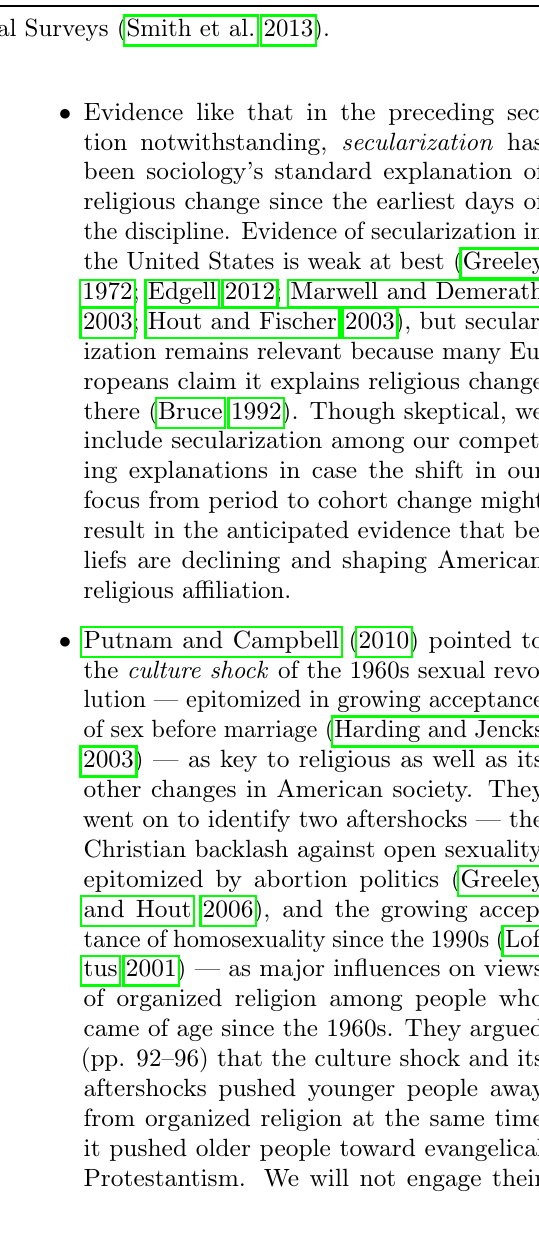
Table 1: Percentage Distributions of the Extent to Which People Describe Themselves as Religious and Spiritual by Some or No Religious Preference: Adults, United States, 2012. Some religion No religion Extent Religious Spiritual Religious Spiritual Very 23 32 3 17 Moderately 46 41 11 23 22 21 Not 9 100 100 100